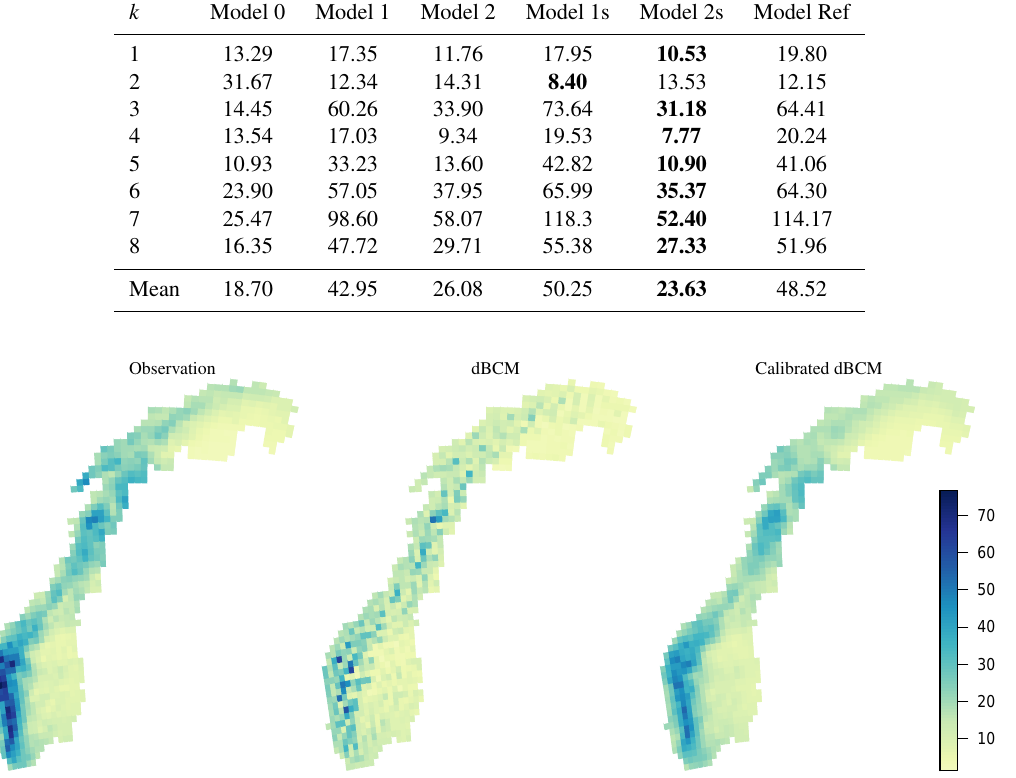
Figure 3. Example calibration for the pointwise 95% quantiles using Model 2s with the dBCM covariate (right). The result is for the final 5-year time period in the cross-validation study. The observed quantiles (left) and uncalibrated dBCM (middle) are shown as